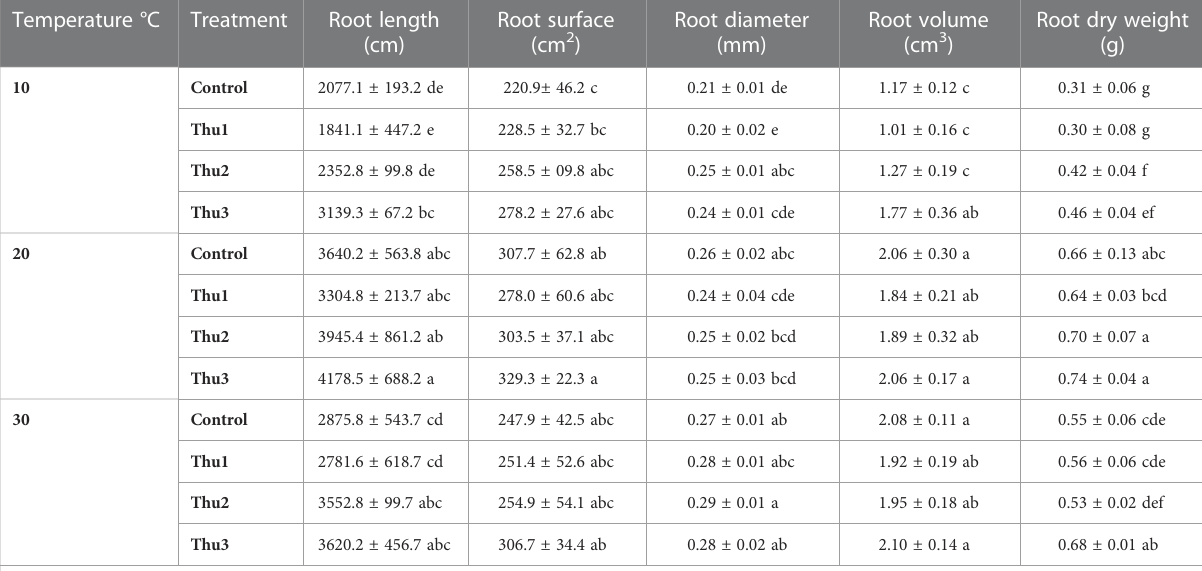
TABLE 2 Effects of temperature and Th17 concentrations on canola root